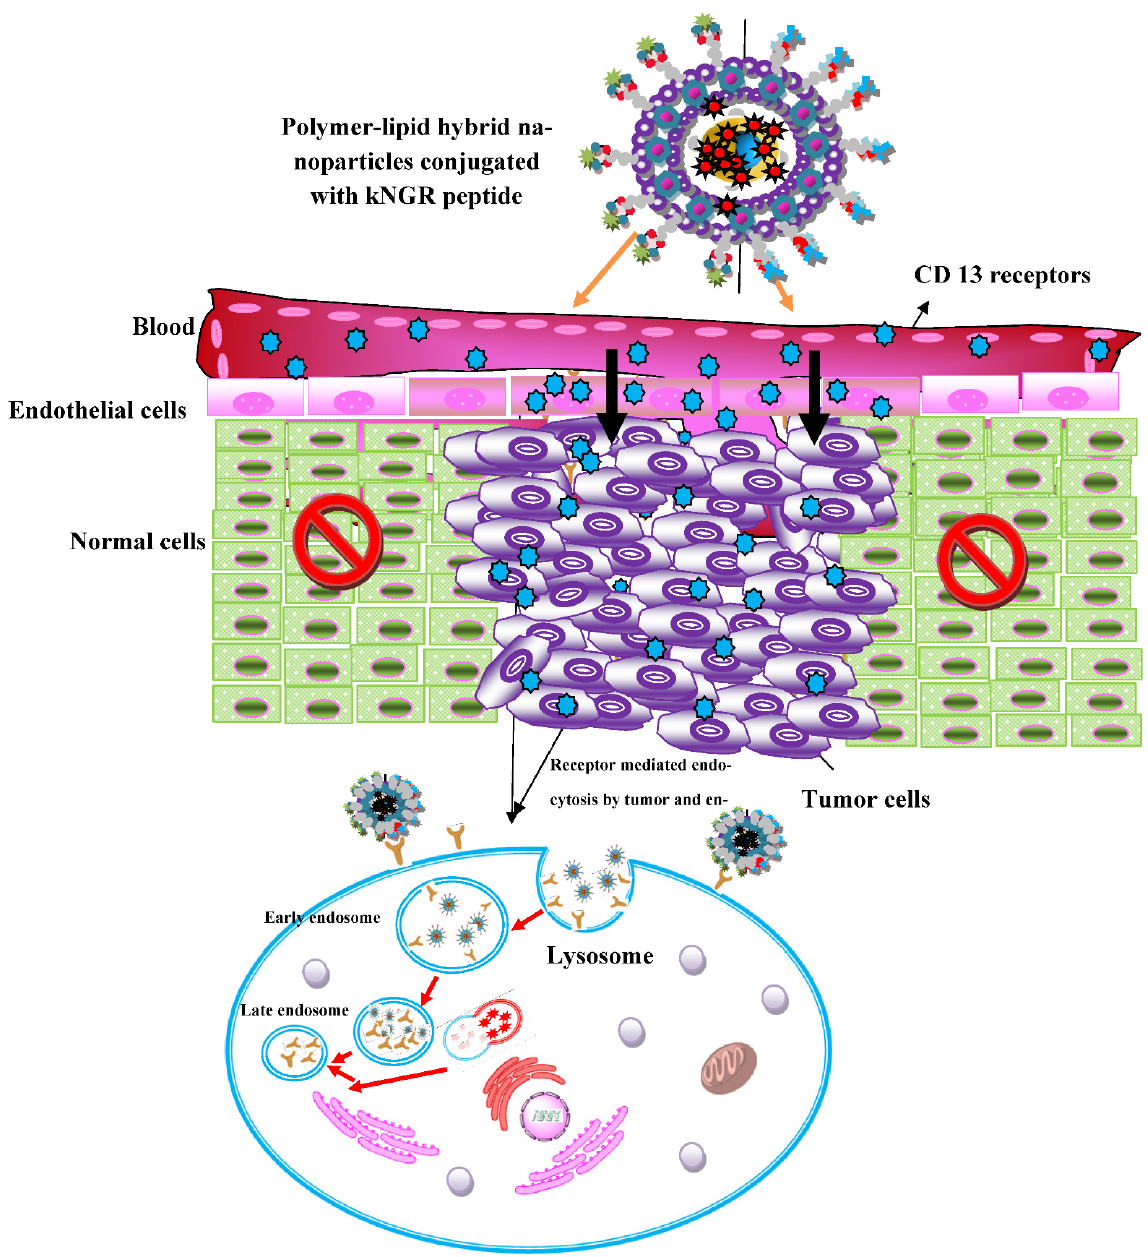
Figure 8. Schematic diagram showing the ligand-conjugated NPs for dual-targeted delivery of solid tumor cells and tumor endothelial cells.